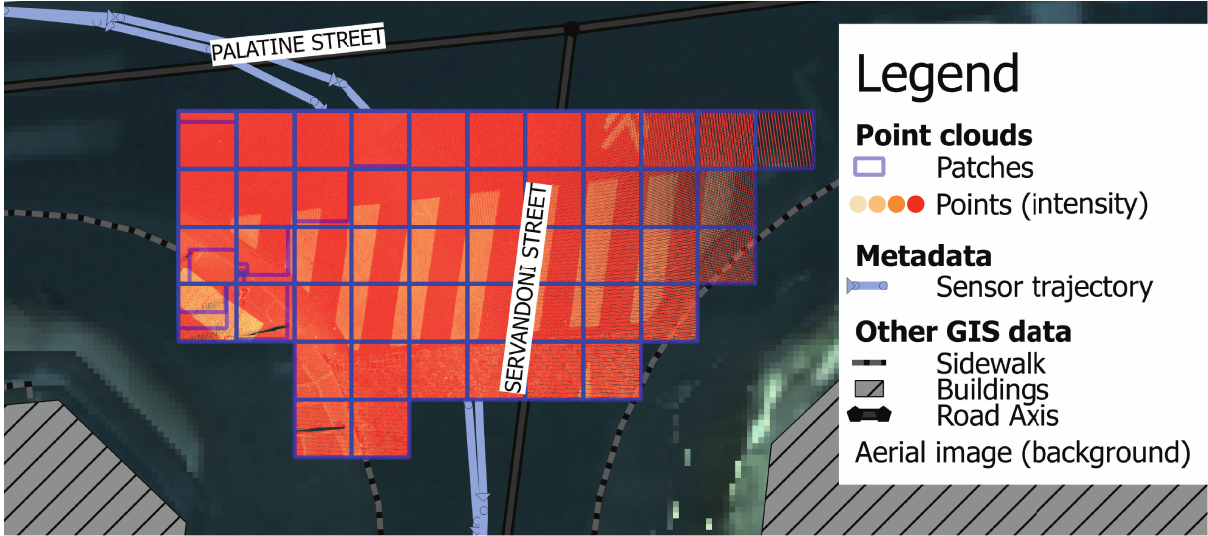
Figure 5: Among billions of points, only those respecting complex filtering conditions are kept. Results are shown in QGIS. Parameters in